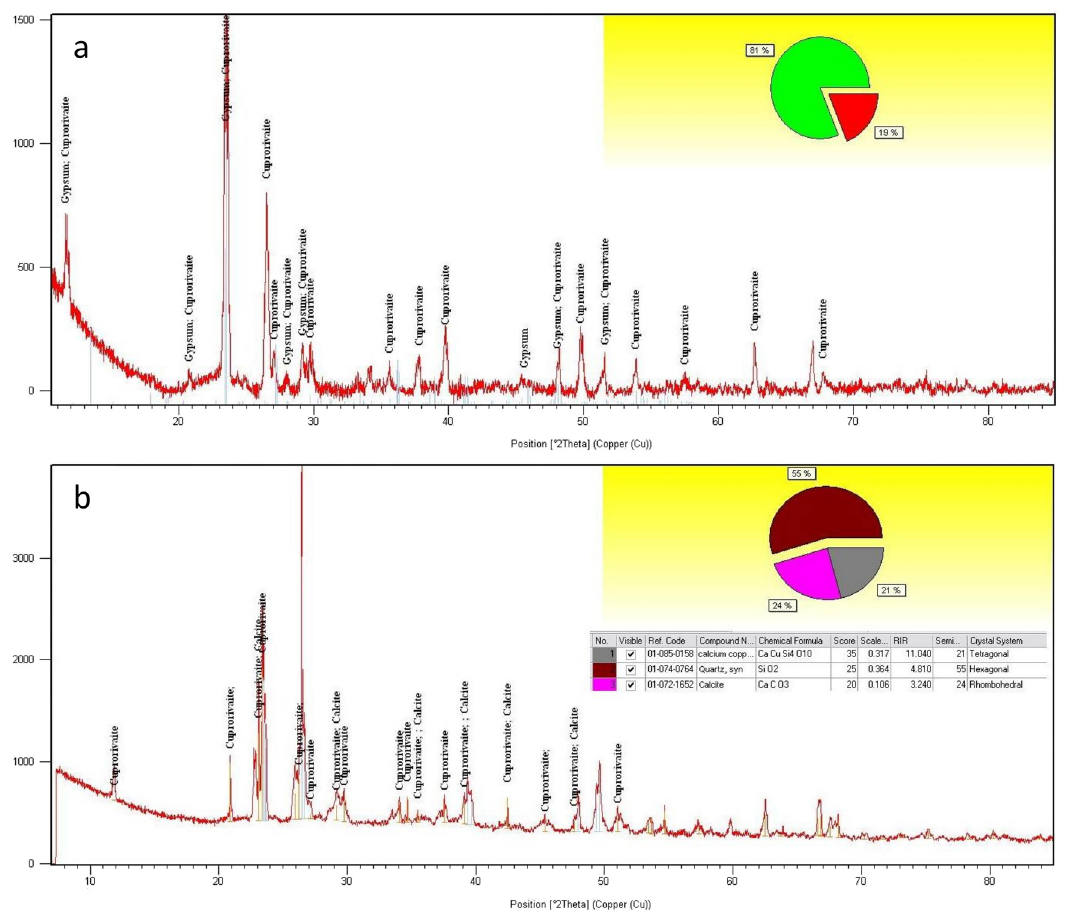
Figure 4: XRD patterns of: ( a ) the blue painted layer ( Object GEM 3163, Spot 1 ) and ( b ) the greenish blue painted layer ( Object GEM 3173, Spot 9 )